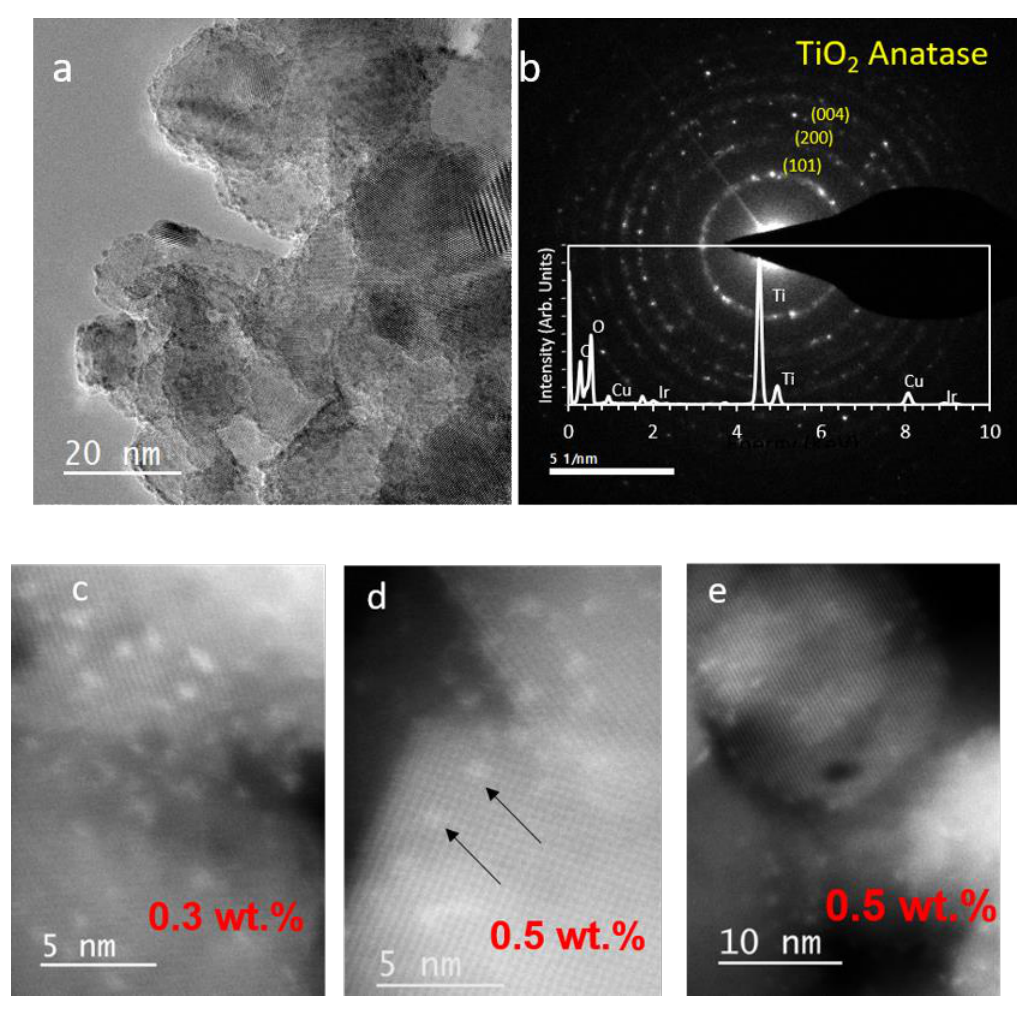
Figure 2. Bright and dark field TEM images of IrO 2 /TiO 2 catalysts. ( a ) TEM image of the 4 wt.% IrO 2 /TiO 2 ; ( b ) a selected area electron diffraction (SAED) pattern of ca 0.2 µm 2 ; inset: respective EDX analysis in which Ir is shown; the Cu EDX signal is from the grid. The SAED image of a catalyst area shows diffraction patterns corresponding to the (101), (200), and (004) crystallographic planes for the TiO 2 anatase support. ( c – e ) HRSTEM images for 0.3 and 0.5 wt.% Ir on TiO 2 anatase at different magnifications. The arrows in ( d ) point to a possible Ir 4+ substitution of Ti 4+ cations in the TiO 2 anatase lattice.